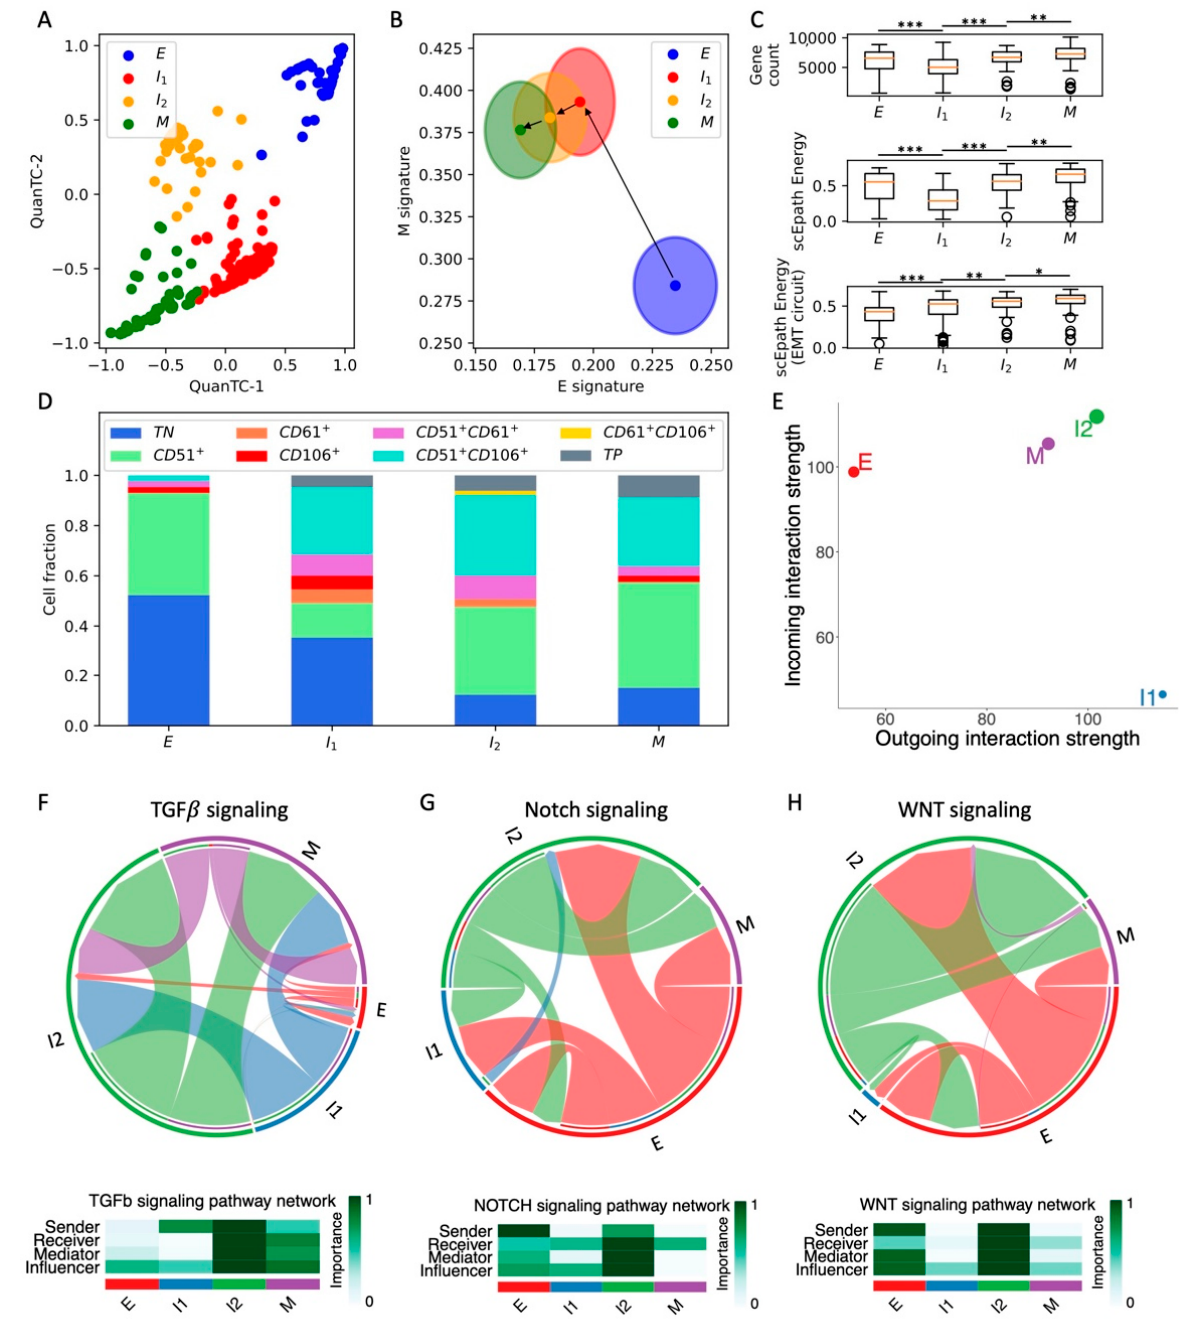
Figure 1. Analysis of EMT, stemness, and cell–cell signaling in the SCC dataset. ( A ) Low-dimensional representation of cells in the SCC dataset. x - and y -axis represent QuanTC coordinates. ( B ) Projection of clusters in the E-M signature space. The center and radius of each circle represent the average scores and standard deviations of the epithelial and mesenchymal signatures within each cluster. Black arrows show the dominant transition trajectory predicted by QuanTC. ( C ) Boxplots depicting the total gene count (i.e., transcriptional diversity, top), scEpath developmental potential (middle), and scEpath EMT circuit energy (bottom) in the four clusters. ( D ) Cluster composition based on CD51, CD61, and CD106 markers. ( E ) Low-dimensional projection of cell clusters in an incoming/outgoing signaling strength computed with CellChat. ( F – H ) Chord diagrams representing the signaling between clusters through Notch ( F ), WNT ( G ), and TGF-beta ( H ) reconstructed with CellChat. Heatmaps quantify the role of each cluster as a sender, receiver, mediator, and influencer. *, **, and *** indicate a p -value < 0.1, 0.01, and 0.001 on a one-tailed t -test, respectively.